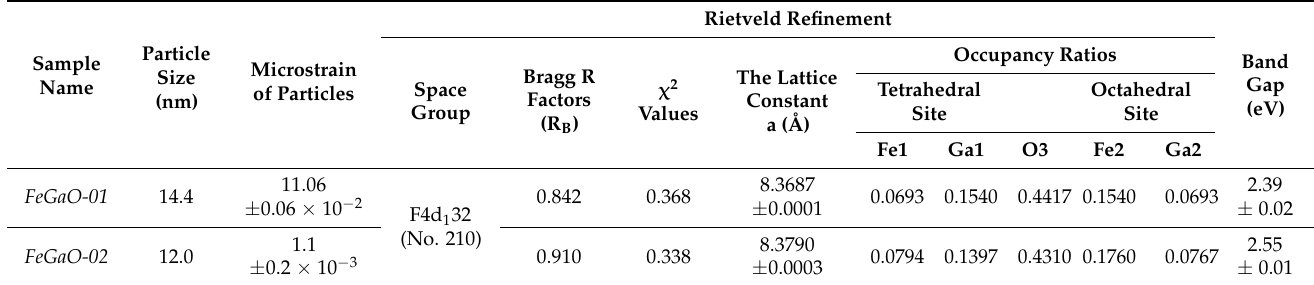
Table 2. Rietveld refinement data and the band gap values of samples.